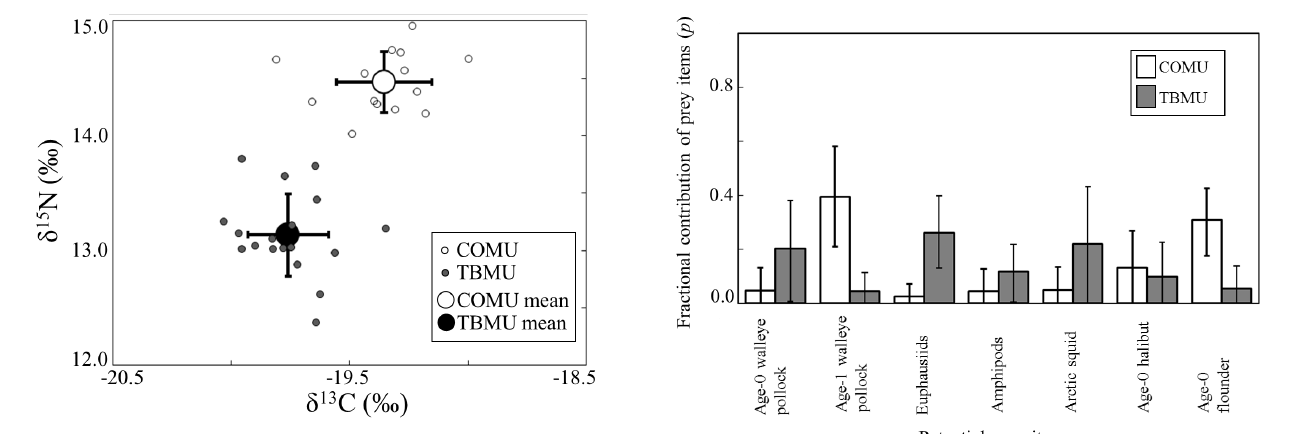
Figure 5. Carbon ( δ 13 C) and nitrogen ( δ 15 N) stable isotopic ratio values of common murres (COMU: open circles) and thick-billed murres (TBMU: closed circles) measured in red blood cells. Smaller circles show individual data, and larger circles with error bars show means ± standard deviation (SD).